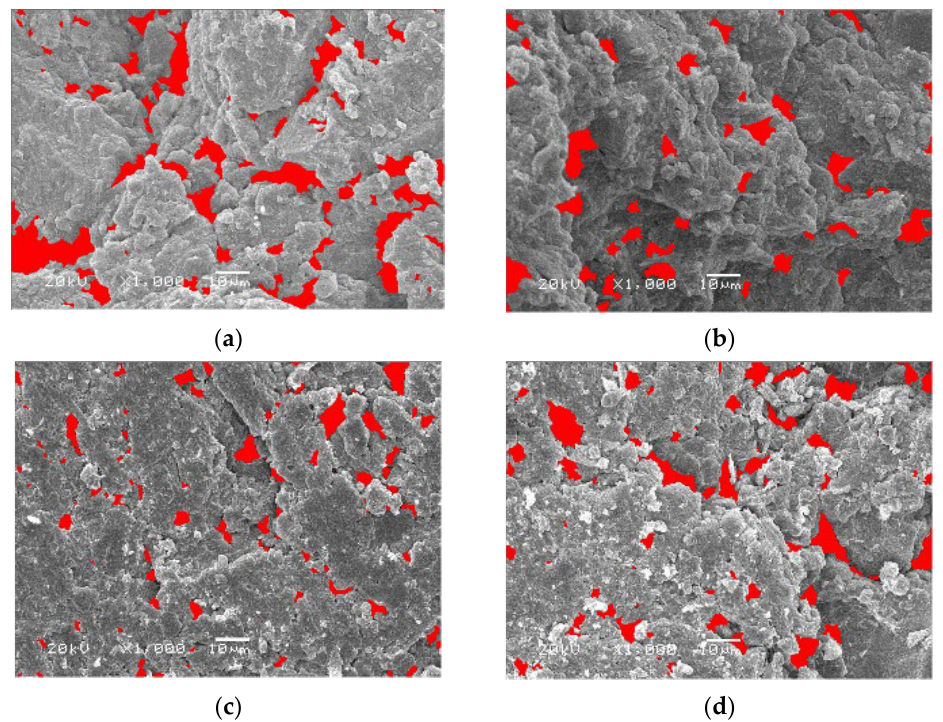
Figure 9. Microscopic pore distribution of F1 reinforced red clay (1000 times). ( a ) Undisturbed red clay. ( b ) 0.3 L/m 3 . ( c ) 0.5 L/m 3 . ( d ) 0.7 L/m 3 .